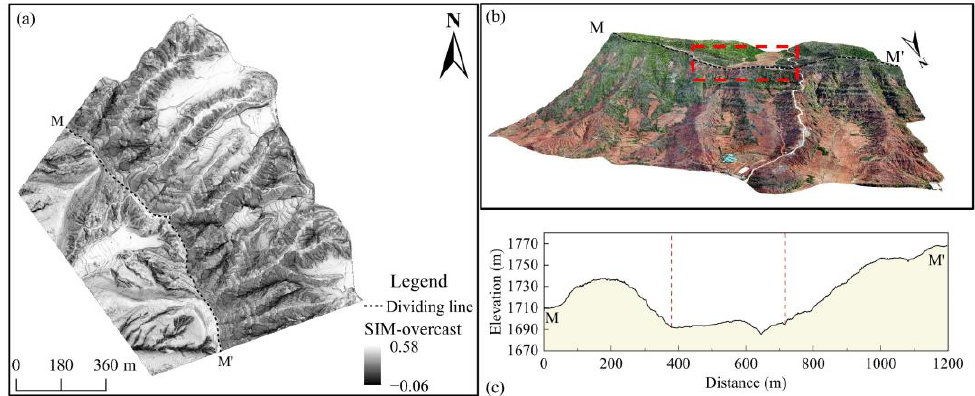
Figure 4. ( a ) The dividing line extraction based on SIM-overcast, ( b ) the dividing line display combined with 3D model, and ( c ) the dividing line elevation.